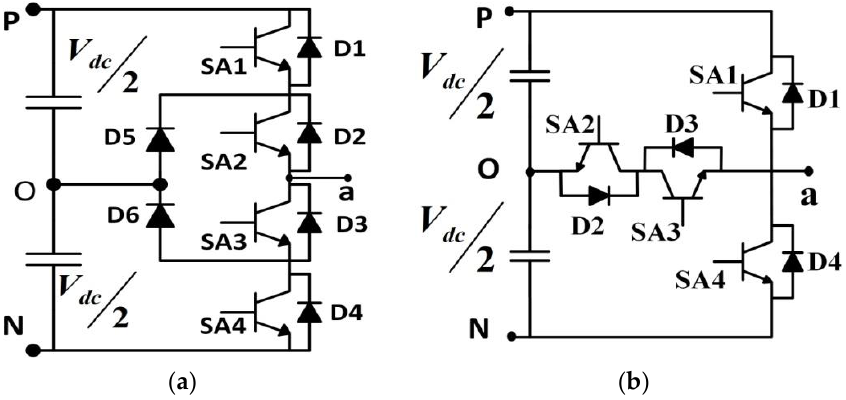
Figure 5. One phase leg of ( a ) the diode clamped VSI, and ( b ) the T-type VSI. Table 2. Switching states of Diode clamped and T-Type VSI